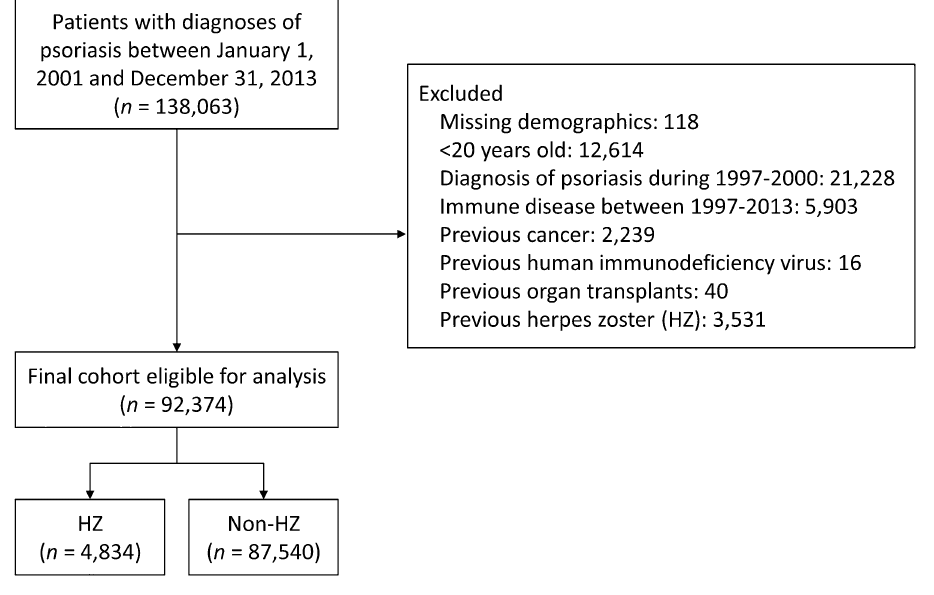
Figure 1. Flowchart of patient